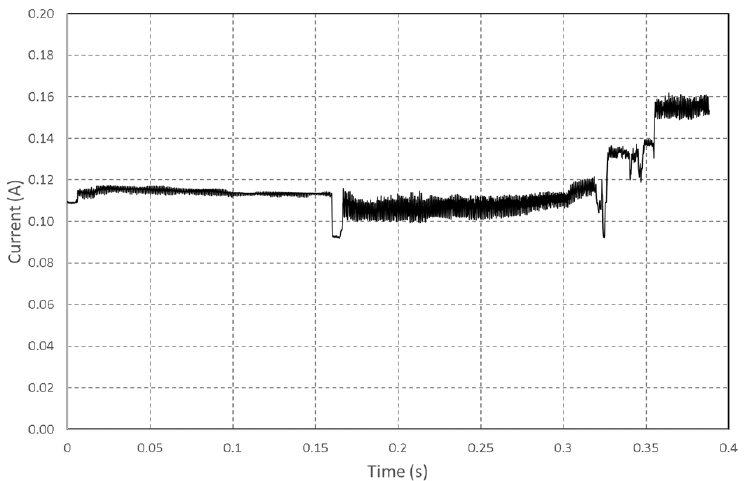
Figure 5. Measured current during